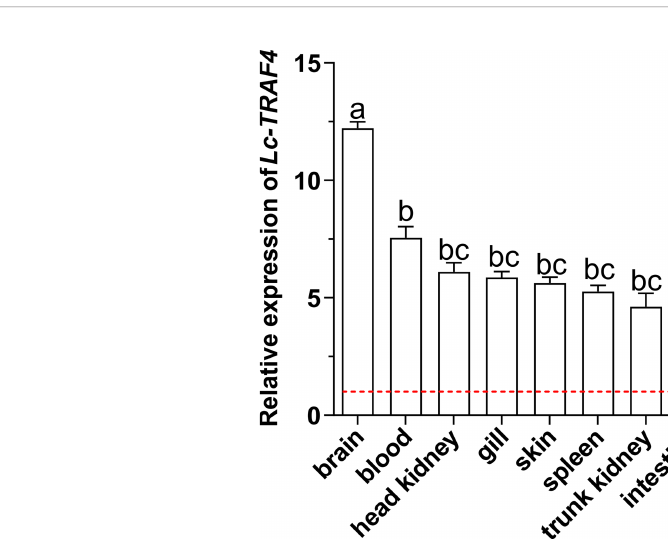
FIGURE 3 | Distribution patterns of Lc-TRAF4 mRNA in large yellow croaker. The expression patterns of Lc-TRAF4 mRNA in 11 different tissues/organs of healthy large yellow croakers were detected by qRT-PCR analysis, with the results normalizing to the expression of b -actin . The mRNA expression level of Lc-TRAF4 in the heart was set as 1-fold, and the mRNA expression levels of Lc-TRAF4 in other tissues/organs were recorded as multiple of the expression level in the heart, and the baseline of 1-fold was marked with the red dotted line. All data were expressed as mean ± standard error (SE) (n = 6). Statistical analysis was performed using a one-way ANOVA followed by a Duncan ’ s multiple range test. Different superscripts indicate statistically different results ( P < 0.05), and the same superscript indicates no statistical differences between groups.